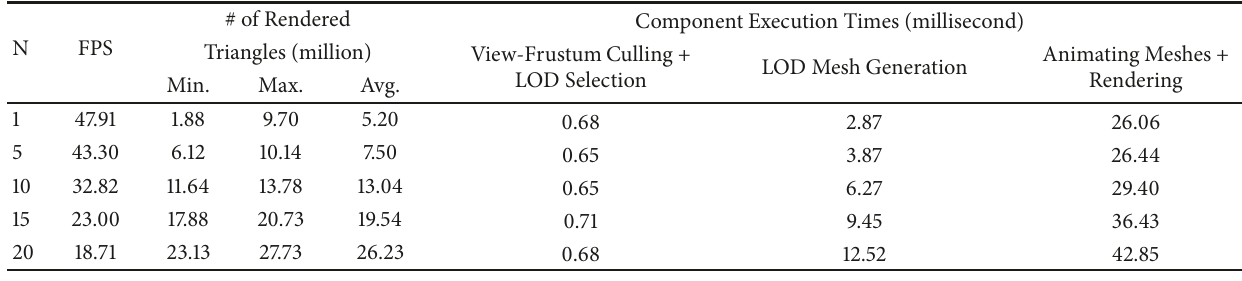
Table2:Performancebreakdownsforthesystemwithaprecreatedcamerapathwithtotal30,000instances.TheFPSvalueandthecomponent execution times are averaged over 1000 frames. The total number of triangles (before the use of LOD) is 169.07 million.